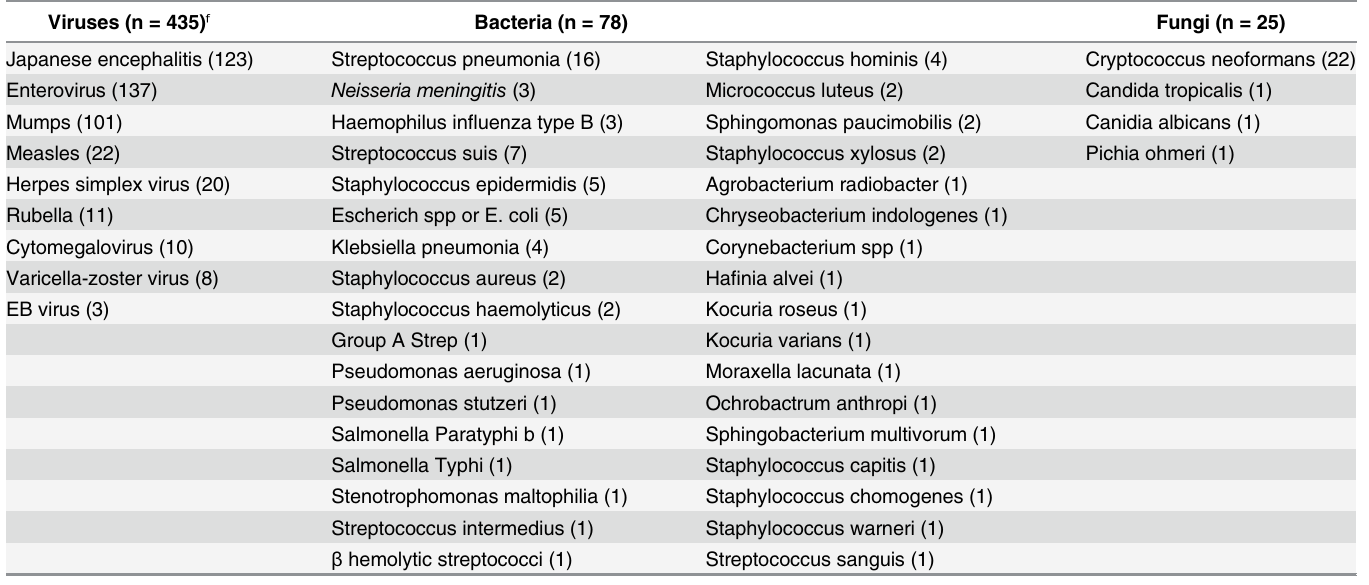
Table 2. Frequency of acute meningitis and encephalitis pathogens in Guigang City, Guangxi, May 2007- June 2012 * . Viruses (n = 435) ᶠ